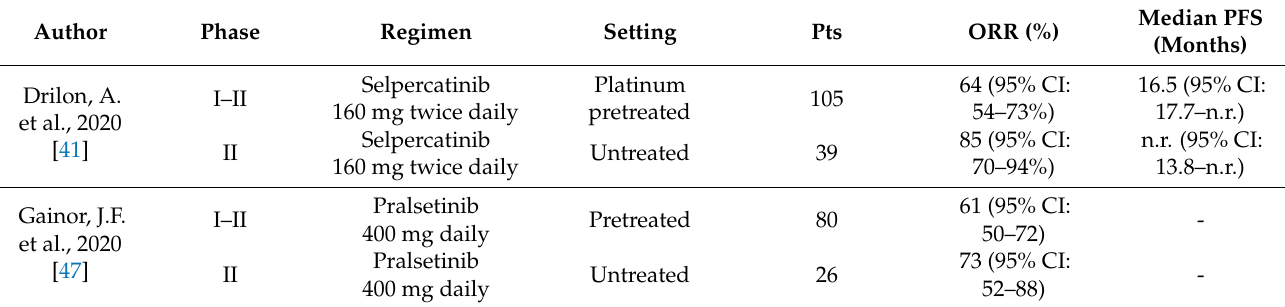
Table 2. Selective RET inhibitors in RET+ NSCLC